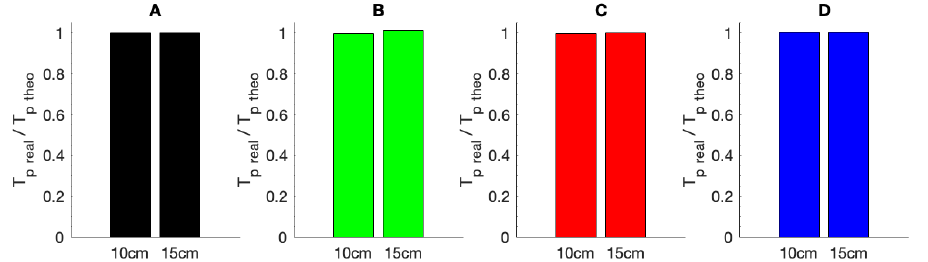
Figure 12. Ratio of realised ( T p T p = 1.81 s, Hs = 10 cm, and 15 cm sea-states for facilities ( A – D